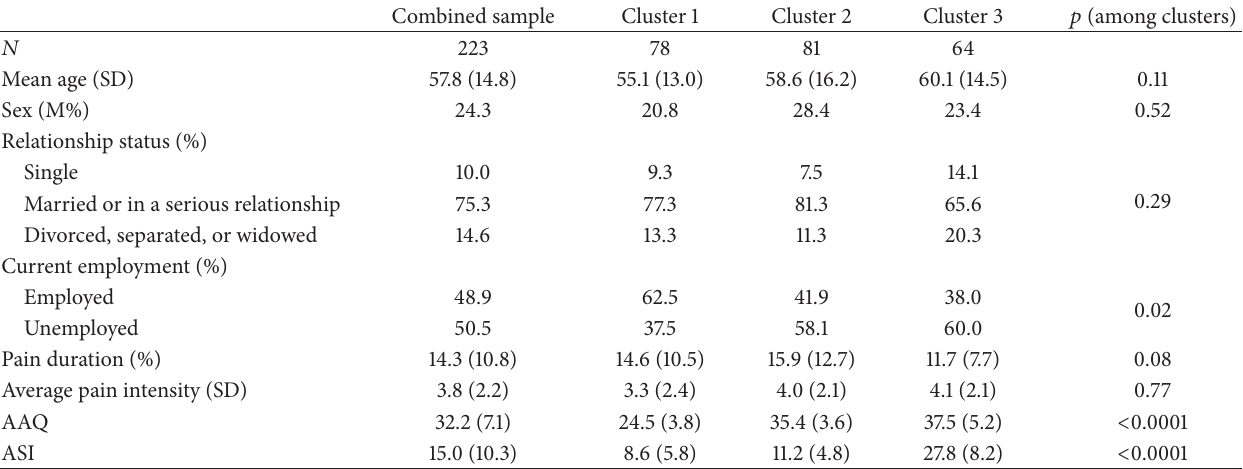
Table 1: Demographic and clinical characteristics of study population and participants aggregated into the three cluster